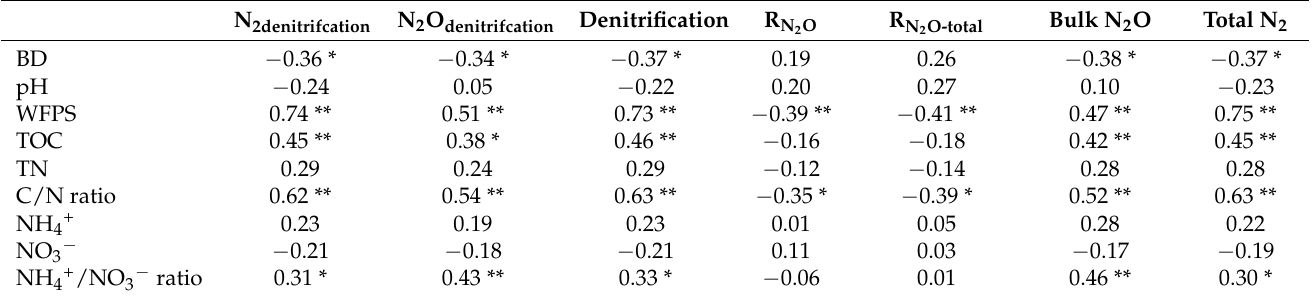
Table 3. Pearson correlations between soil properties and fluxes, ratios of N 2 and N 2 O emissions in the mixed forest of Qingyuan station in Northeast China.